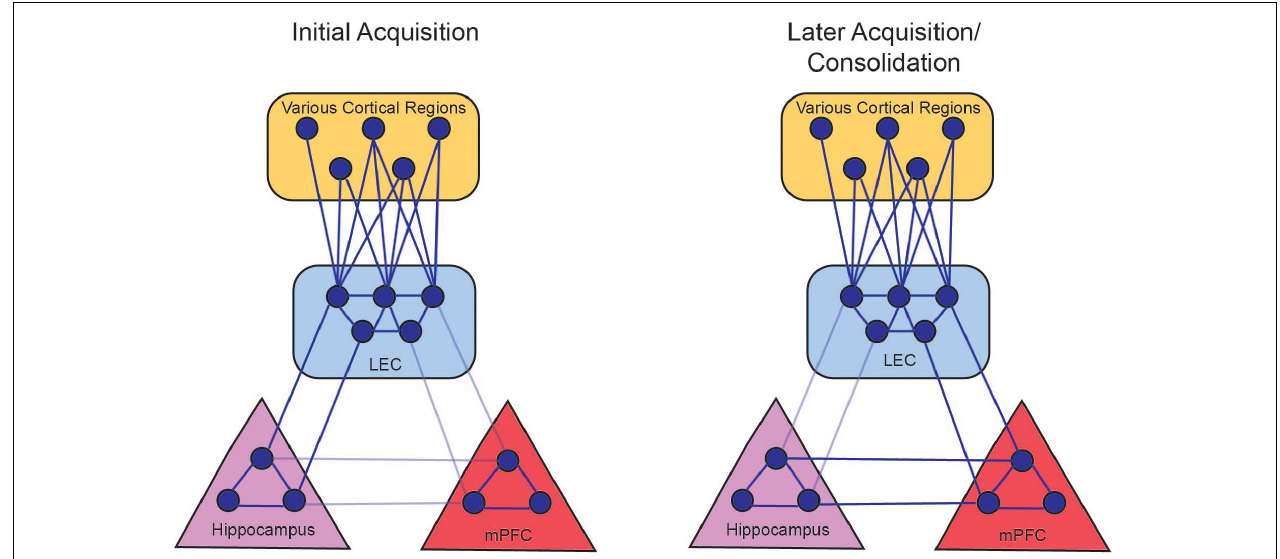
FIGURE 6 | Persistent firing allows for the LEC to couple with hippocampal and prefrontal activity. During the initial acquisition of tEBC (left panel), persistent firing in LEC III allows for the LEC to synchronize with hippocampus oscillations in the theta range (solid lines). This allows the hippocampus to coordinate processed information from various cortical regions. Persistent firing also allows the LEC to couple with the mPFC, although this connection is not stabilized (faded lines) before the animal starts exhibiting increased CRs. During late acquisition and consolidation (right panel), LEC-hippocampus activation allows the LEC to strengthen connections with the mPFC, so the mPFC can take over the role of integrating the various cortical nodes that represents the memory. The LEC-hippocampus connection decreases in late acquisition (faded lines) as the LEC-mPFC connection strengthens (solid lines). There is also a projection from the hippocampus to the mPFC that can also support the consolidation of the memory (Takehara-Nishiuchi, 2014). From Lin